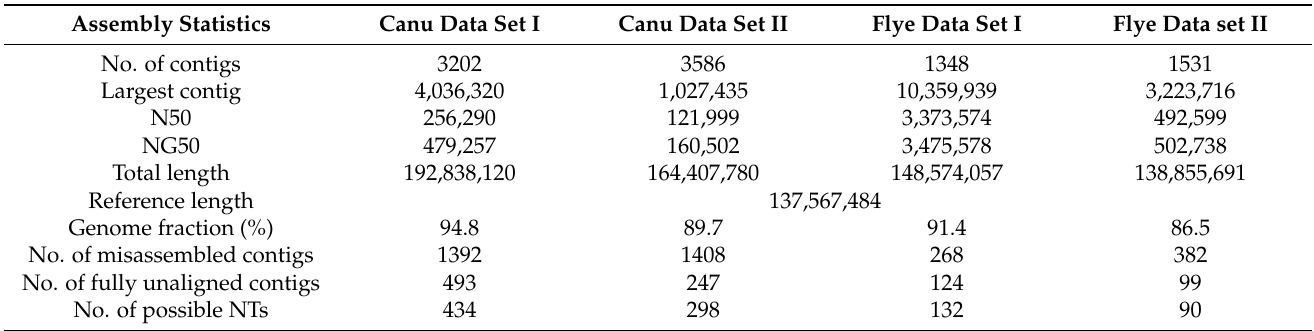
Table 3. QUAST-LG statistics for the de novo assemblies obtained with Canu and Flye using Data set I and Data set